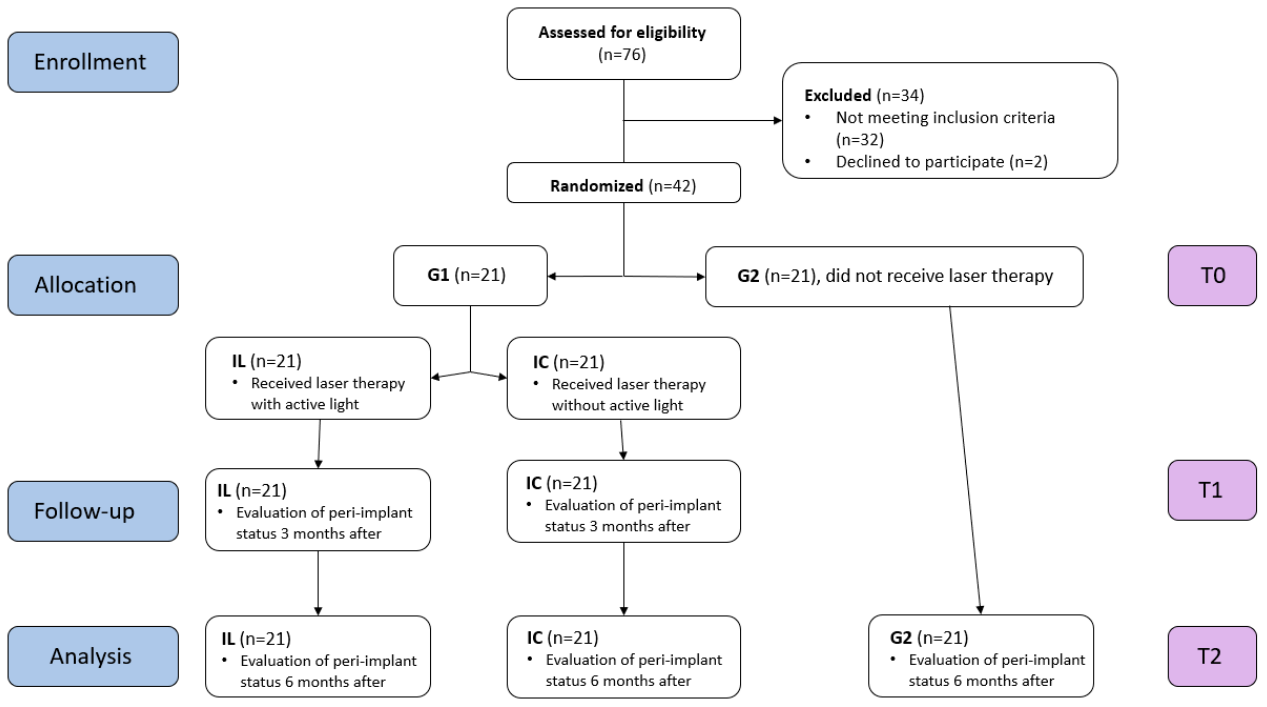
Figure 1. Flow diagram of the study.